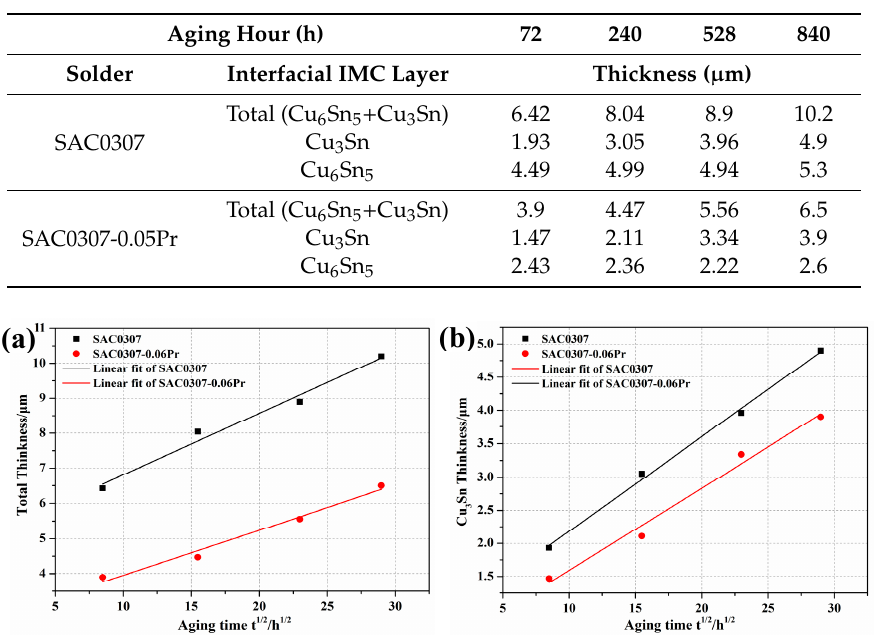
Table 2. Detailed thickness change with aged time at the interfaces of solders / Cu.